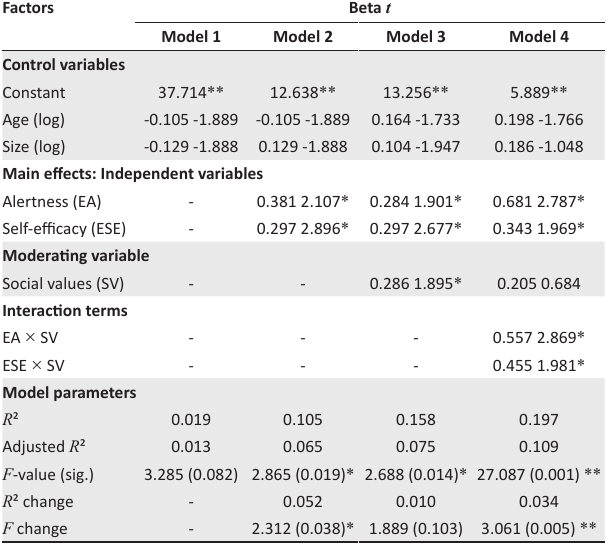
TABLE 3: Results of hierarchical regression as moderated by social values .